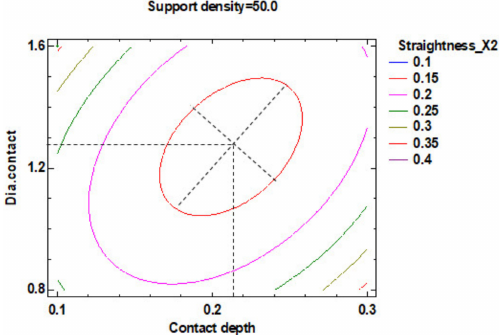
Figure 20. Contours of Estimated Response Surface for Straightness_X2 and centre support